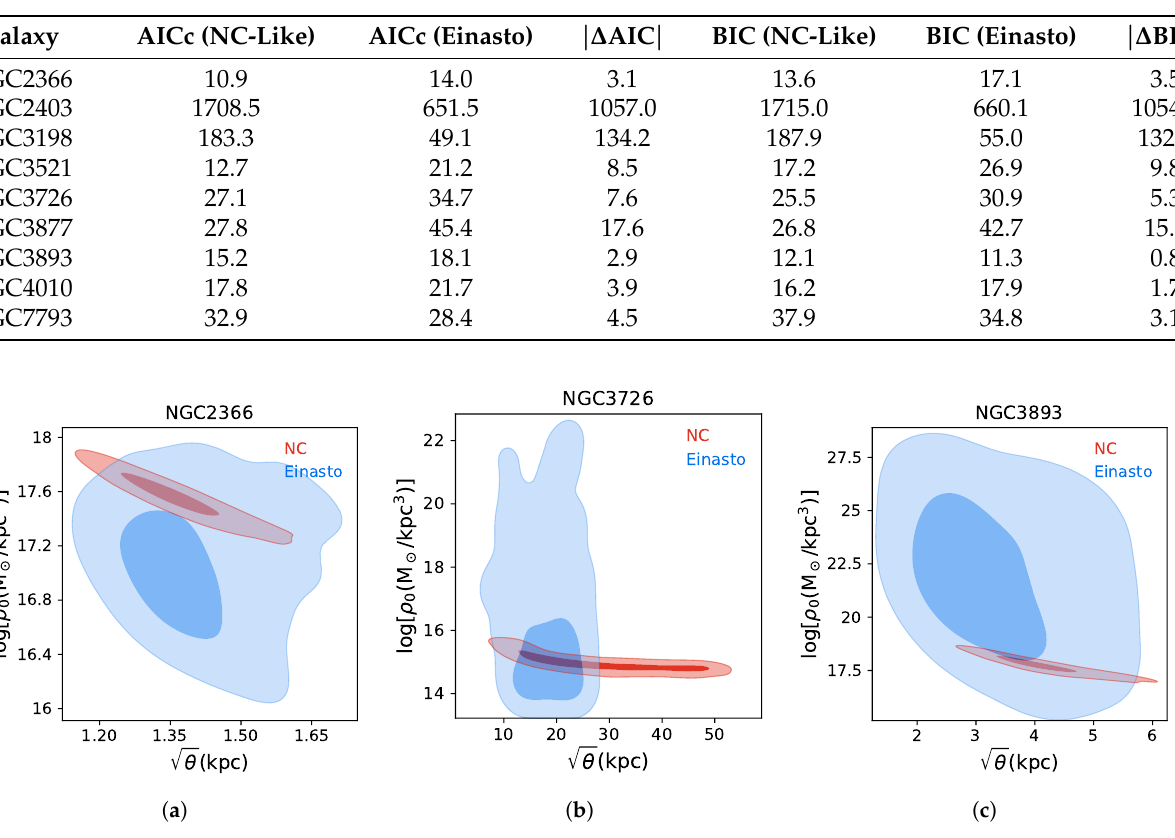
Figure 2. Contours at 1 and 2 σ CL of NGC2366, NGC3521 and NGC7793 for NC-like and Einasto profiles in the parameters: √ θ , ( r − 2 /2). The corresponding mean value of the spectral index in the Einasto model is n ≤ 1.3. central density ρ 0 and Darker region represents 1 σ and lighter region is 3 σ .